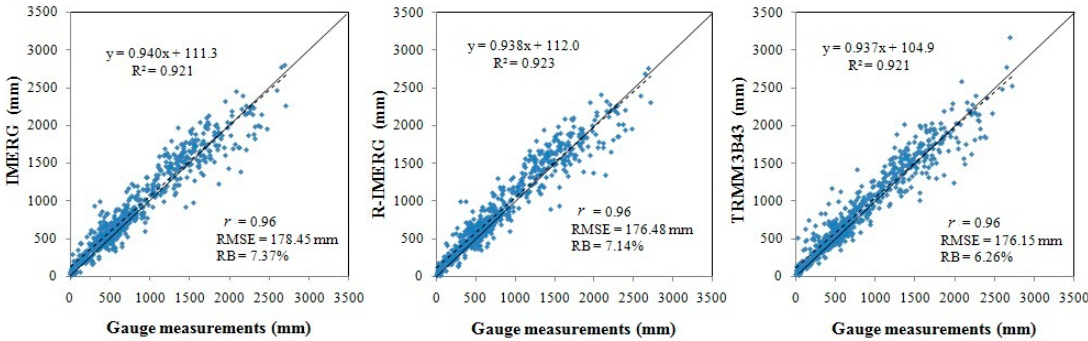
Figure 3. Scatter plots of gauge measurements versus annual precipitation estimates derived from IMERG, R-IMERG, and TRMM 3B43 products over Mainland China.